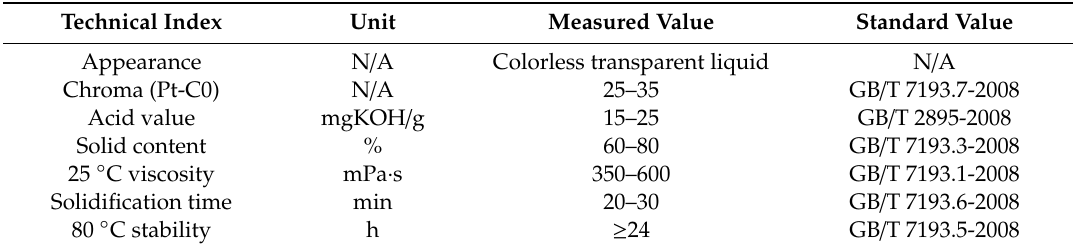
Table A9. Technical parameters of 99A high transparent crystal resin.